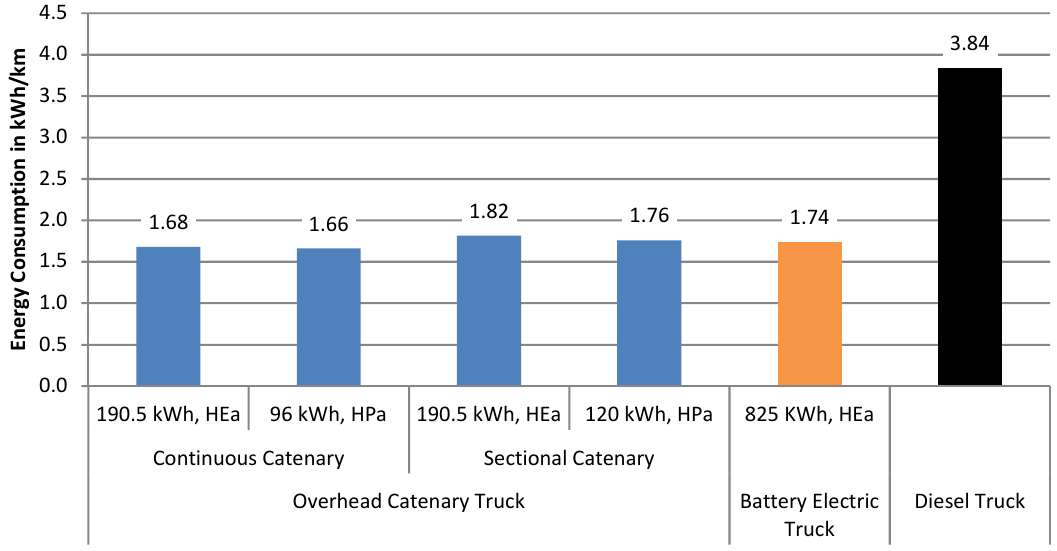
Figure 8. Energy consumption for the overhead catenary trucks with different configurations of catenary and traction batteries compared to battery electric truck and diesel truck.